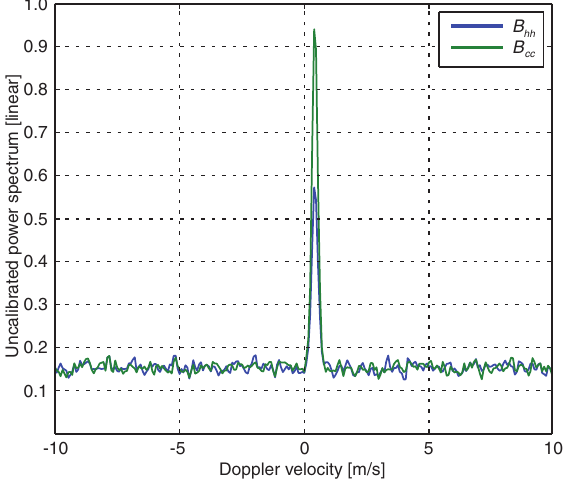
Figure 6. Power spectrum in the horizontal channel (blue line) and power spectrum after coherent averaging (green line). The same data as in Fig. 4 are used.